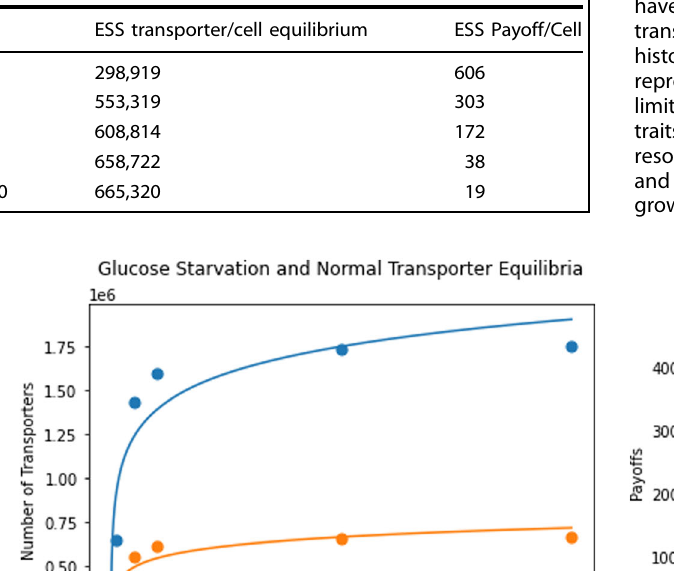
Table 4. Glucose starvation ESS transporter equilibria and payoffs.